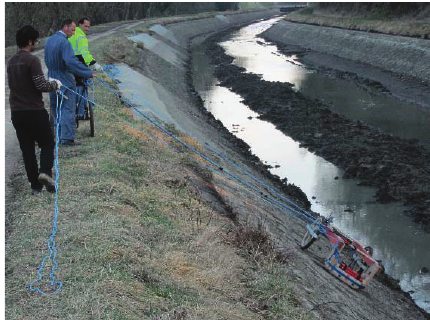
Figure 7: GPR acquisition on the paved revetment of the embank- ment.